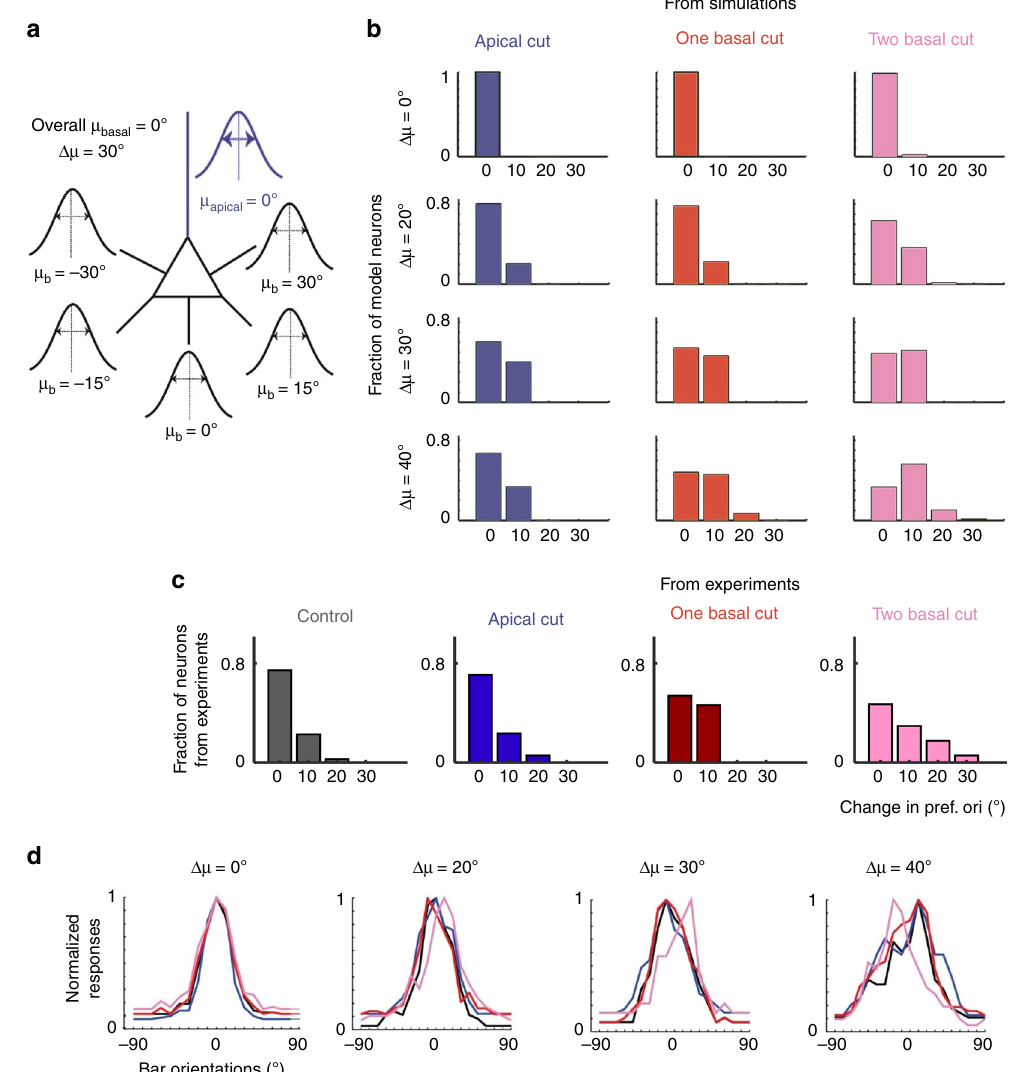
Fig. 5 Simulated neurons with differentially tuned basal dendrites reproduce effects of ablation. a Example simulation schematic for disparity of orientation preference across basal dendrites, Δμ = 30°. μ b (mean orientation preference of tuned inputs of a given primary basal dendrite) was selected from a de fi ned disparity μ b ∈ { − Δμ … μ basal … Δμ }. Mean of pref syn in the apical ( µ apical ) and basal ( µ basal ) were arbitrarily set to 0°. σ apical = 30° and σ b = σ basal = 15° for all basal dendrites. b Increasing disparity between basal dendrites ( Δμ ) leads to a mild shift in orientation preference with two-basal ablation while minimally affecting tuning curves of apical or one-basal ablation. Histogram of post-ablation absolute-value changes in orientation preference of model neurons with Δμ = 0° (same as Fig. 4), 20°, 30°, and 40° after apical (blue), single (red) and double (pink) basal dendrite ablation. For all, mean change in tuning-width is <10° and mean change in OSI is <0.2 (thresholds correspond to the mean + 1std of the experimental data). Δμ of 50° or greater fail to generate tuning curves comparable to experiment (OSI ≤ 0.2, tuning width ≥ 80° for more than 30% of simulated neurons). c In vivo experimental data in the format of ( b ), reproduced for comparison. d Example normalized tuning curves of model neurons with varying Δμ before (black) and after apical (blue), single (red) and double (pink) primary basal dendrite f Δμ , Supplementary Fig. 12). two basal dendrite ablation ( ablated Figure 5 was generated using a narrow distribution of pref syn in basal dendrites ( σ b = σ basal = 15°). σ b ( = σ basal ) of 30° (Supple- mentary Fig. 13) also induced a shift in orientation preference (max change = 20°, mean = 4.4°) but the fi t to experimental data was worse than σ b = 15°, indicating the need for sharply tuned input structures into basal dendrites.